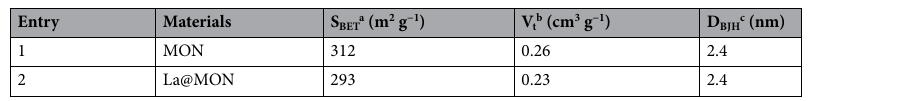
Table 1. Textural properties of the synthesized materials were determined from nitrogen physisorption data. a S BET : Specific surface area was determined from the linear part of the BET in relative pressure from 0.05 to 0.15. b